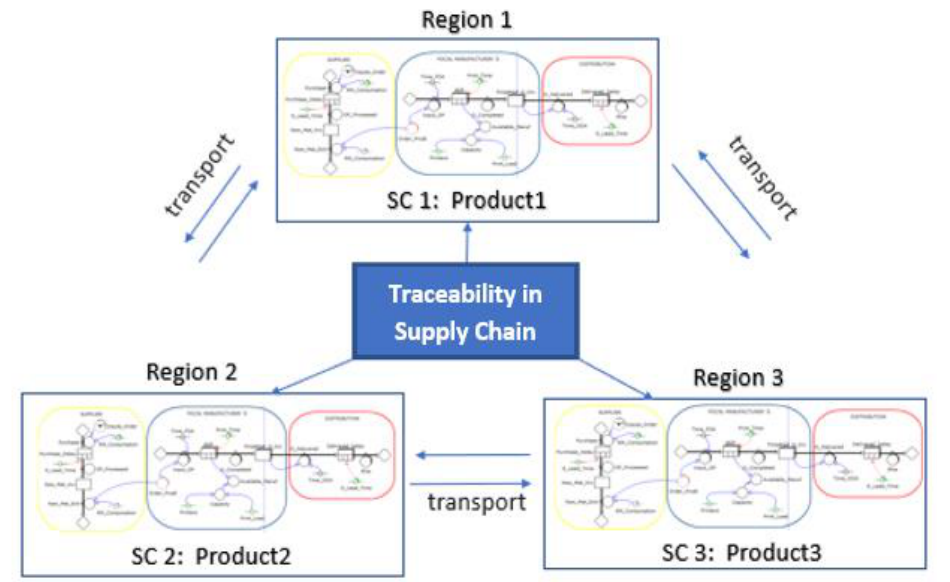
Figure 5. Scenario 1 representation—traditional supply chain. Source: own elaboration.